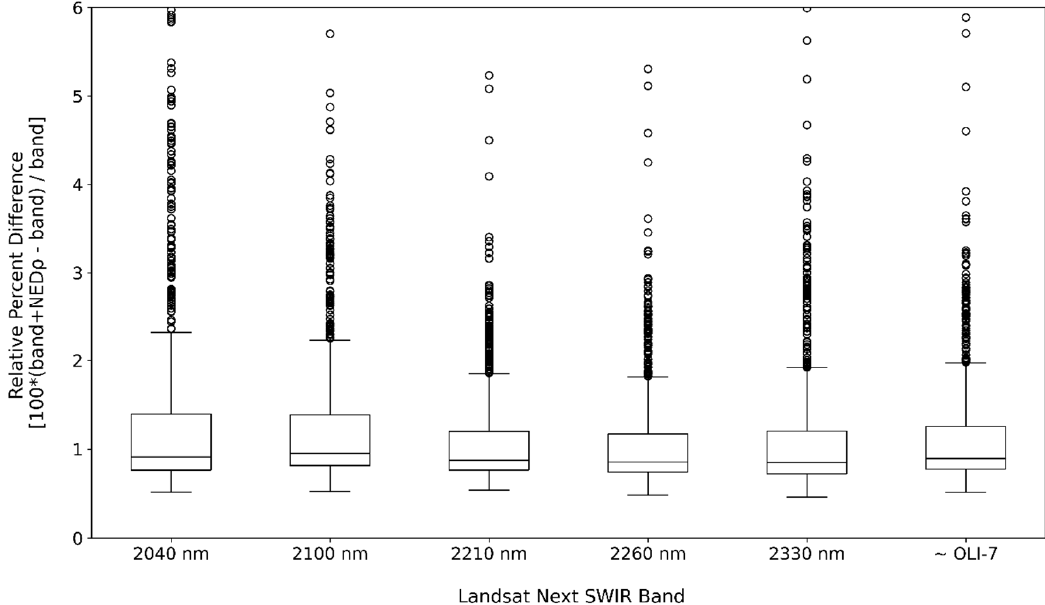
Figure 7. Relative percent difference for shortwave infrared (SWIR) band reflectance computed from difference of reflectance with NED ρ as positive errors/uncertainties. Negative uncertainties have identical absolute values for RPD. This NED ρ uncertainty generally falls in a range of +/ − 0.5% to +/ − 2.5% RPD reflectance with +/ − 1% median RPD reflectance. Bands were calculated using boxcar spectra at 20, 20, 40, 40, 50 nm bandwidth for the 2040, 2100, 2210, 2260, and 2330 nm bands, respectively. An approximation of OLI Band 7 (~OLI-7) was computed from mean of 2100 nm, 2210 nm, and 2260 nm after +/ − NED ρ calculation.